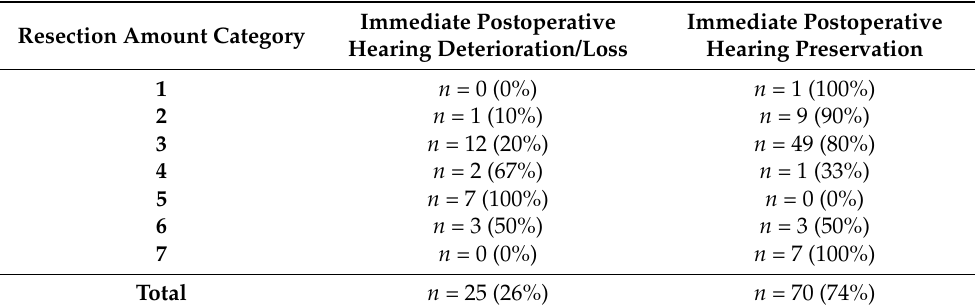
Table 5. Prediction model for immediate audiometric postoperative hearing deterioration/loss and preservation vs. resection amount